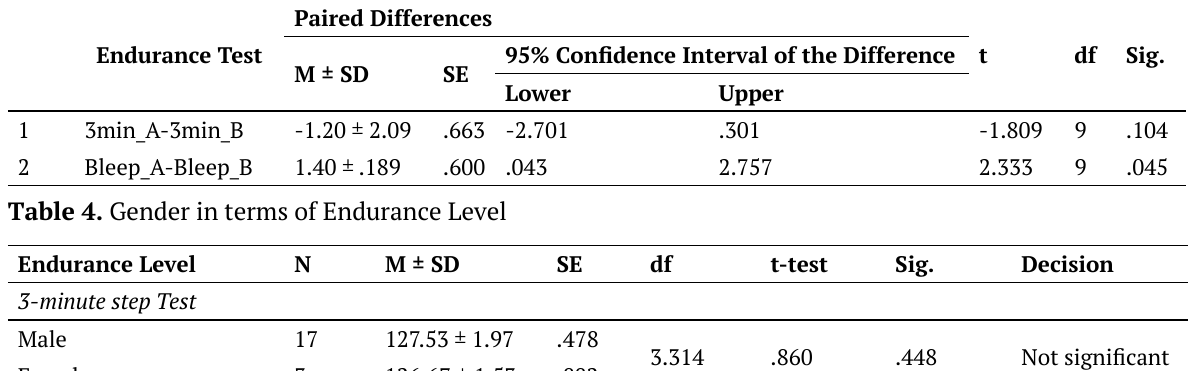
Table 3. Gamers versus non-gamers’ endurance level difference